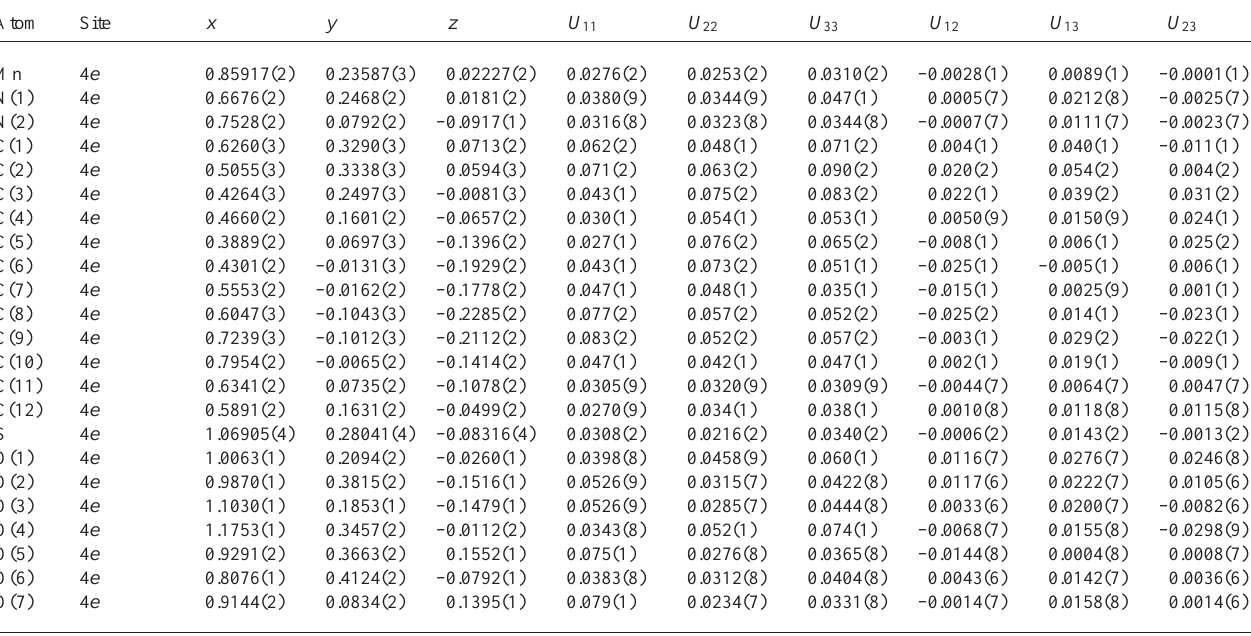
Table 3. Atomic coordinates and displacement parameters (in Å 2 )